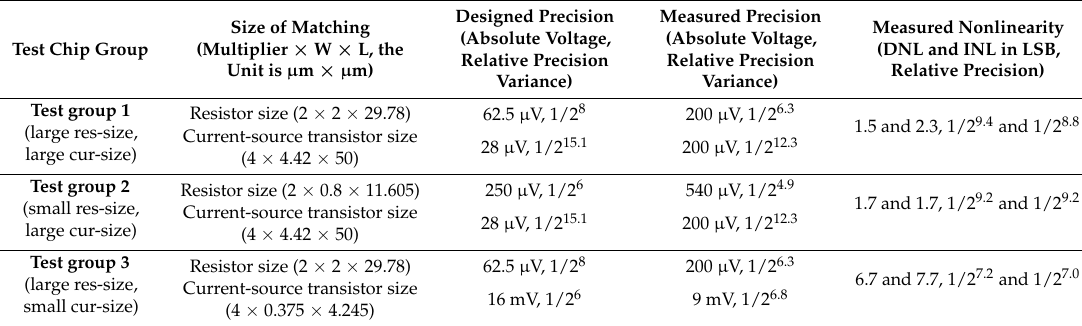
Table 2. The different sizes of resistors and current-source results in different measured nonlinearities.